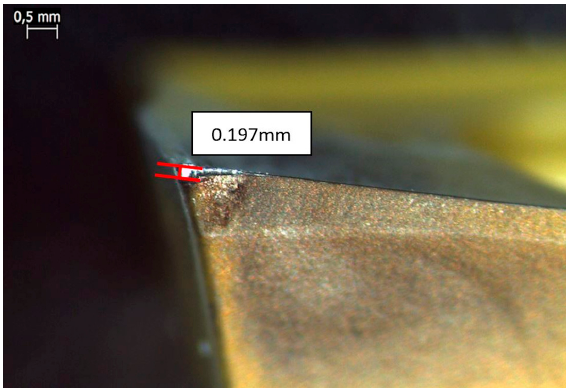
Figure 8. Wear measurement example.